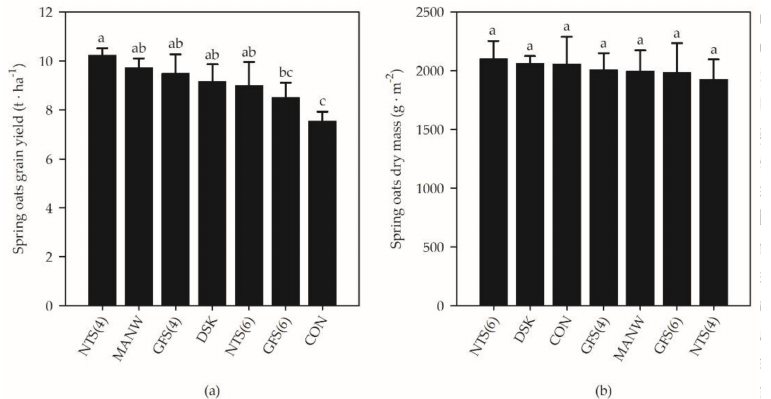
Figure 5. ( a ) Spring oats grain yield; ( b ) spring oats dry mass recorded at Kleinhohenheim in 2017. Means with the same letter are not statistically different according to Duncan’s multiple range test at α ≤ 0.05. CON = untreated control, MANW = manual weeding, GFS(4) = goosefoot sweeps 4 km · h − 1 , GFS(6) = goosefoot sweeps 6 km · h − 1 , NTS(4) = no-till sweeps 4 km · h − 1 , NTS(6) = no-till sweeps